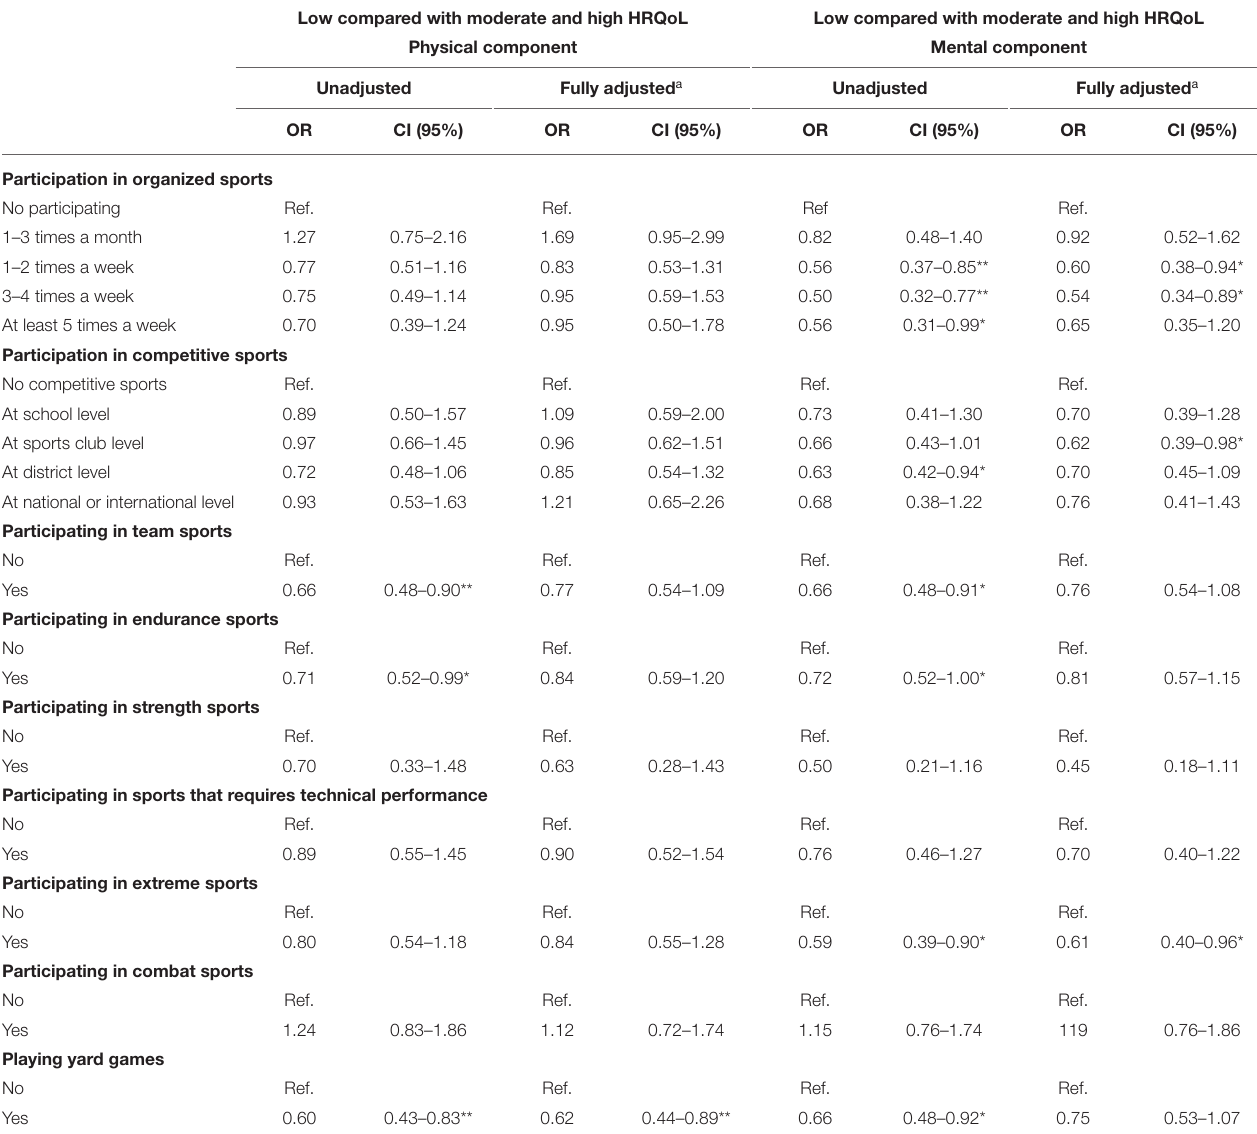
TABLE 3 | Odds ratios (OR) and 95% confidence intervals (CIs) separately for low compared with moderate and high scores in the physical and mental component summary of RAND 36 by variables describing sports participation at age 12 years. Low compared with moderate and high